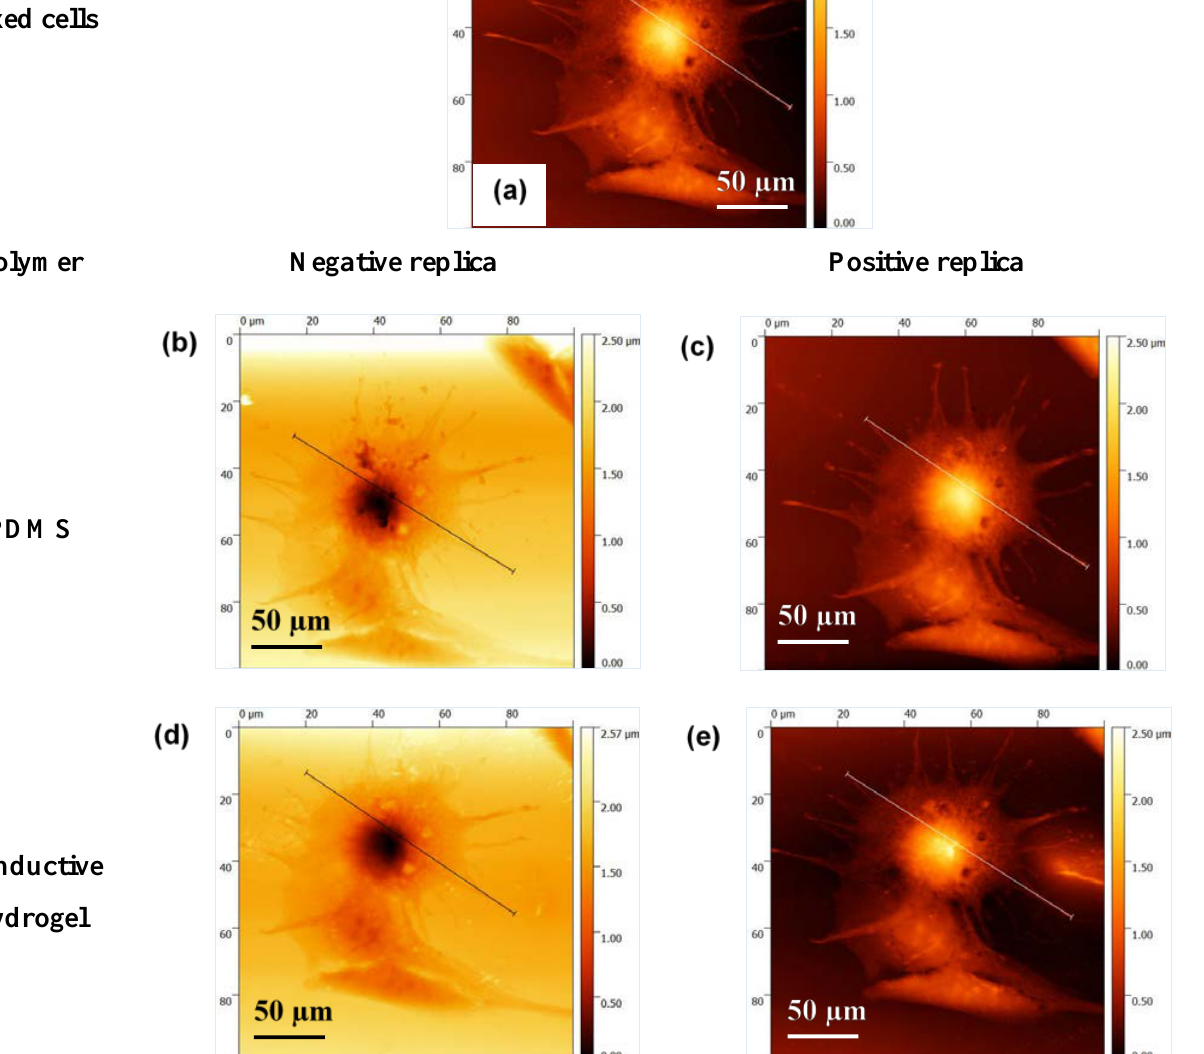
Figure 7. AFM images of a single C2C12 cell ( a ) fixed on the glass, ( b , c ) its negative and positive imprints on PDMS and ( d , e ) its negative and positive imprint on conductive hydrogel after plasma and PVP treatment of PDMS. The lines across the cell indicate the profiles of the cross-section of the cell at each step, which are compared in the next figure.